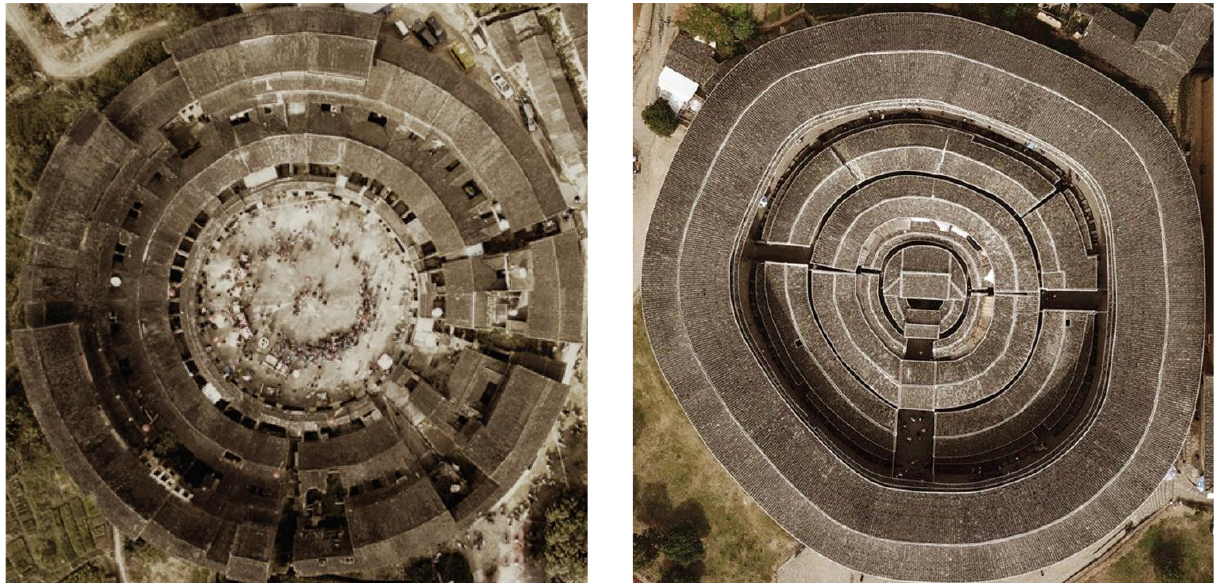
Figure 2. On the left, case study Long Jian Lou, 1662-1722, Pingue County (Minnan Tulou, unit type); on the right, case